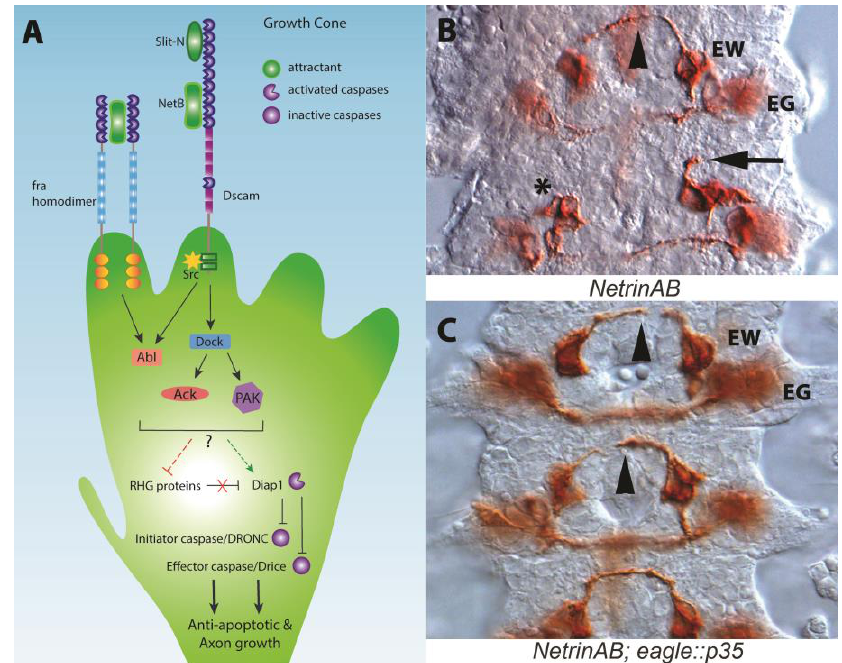
Figure 1. Apoptotic machinery and axons. ( A ) Schematic of axon guidance signaling pathways that potentially interact with the apoptotic